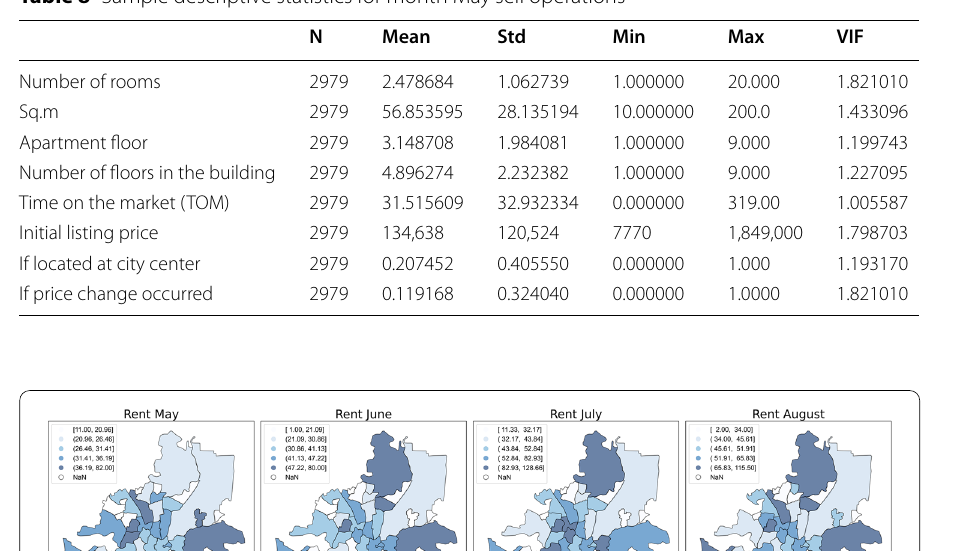
Table 8 Sample descriptive statistics for month May sell operations